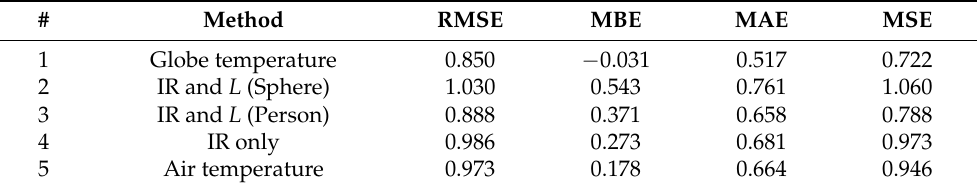
Figure 5. Boxplots of the difference in mean radiant temperature ( T mrt ) (K) between the reported measurements of a Kestrel 5400 Heat Stress Tracker and the MoBiMet using the five different calculation methods (Table 2). Sorted by the light level (lx) measured by the MoBiMet in an office in Freiburg between 4 August and 17 August 2021. Table 3. Root mean square error (RMSE), mean bias error (MBE), mean absolute error (MAE), and mean squared error (MSE) for the different methods of the mean radiant temperature ( T mrt ) (K) from a MoBiMet in an office, relative to an adjacent Kestrel 5400 Heat Stress Tracker.